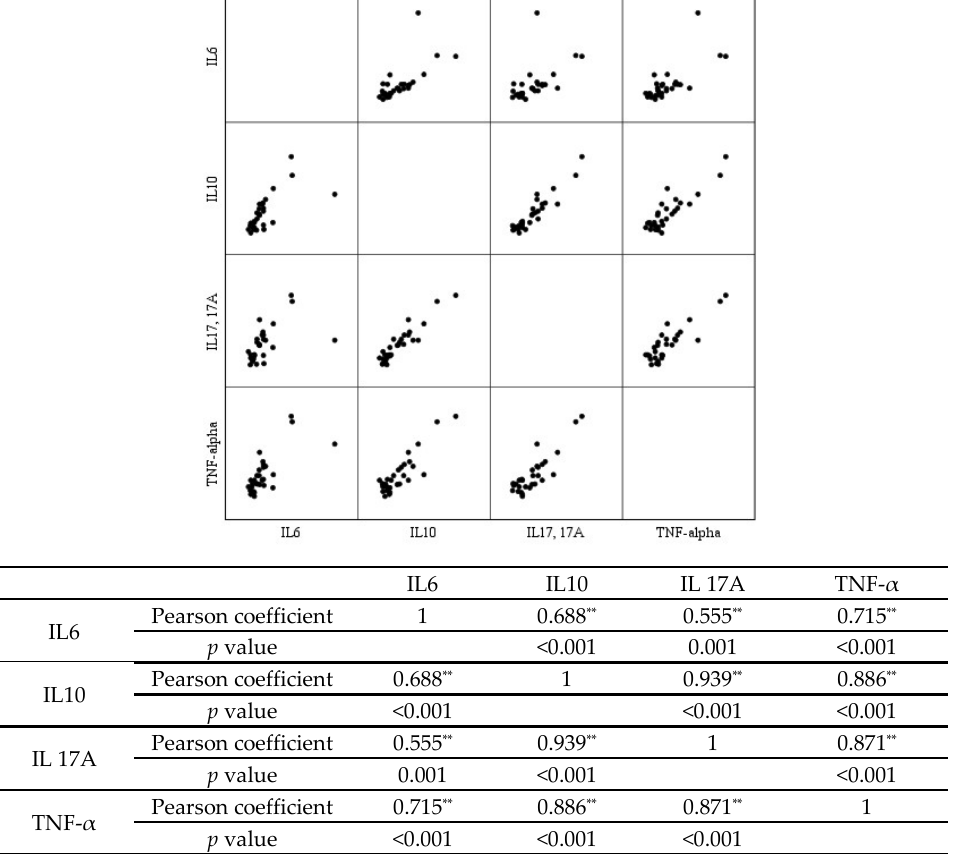
Figure 2. Correlation between each cytokine evaluated by scatterplot and Pearson correlation analysis. IL; interleukin, and TNF; tumor necrosis factor.